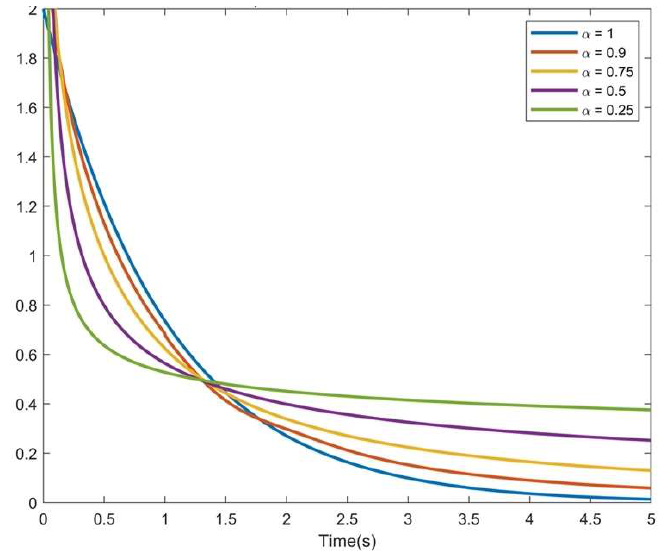
Figure A2. Impulse Response for various values of 𝜶 .